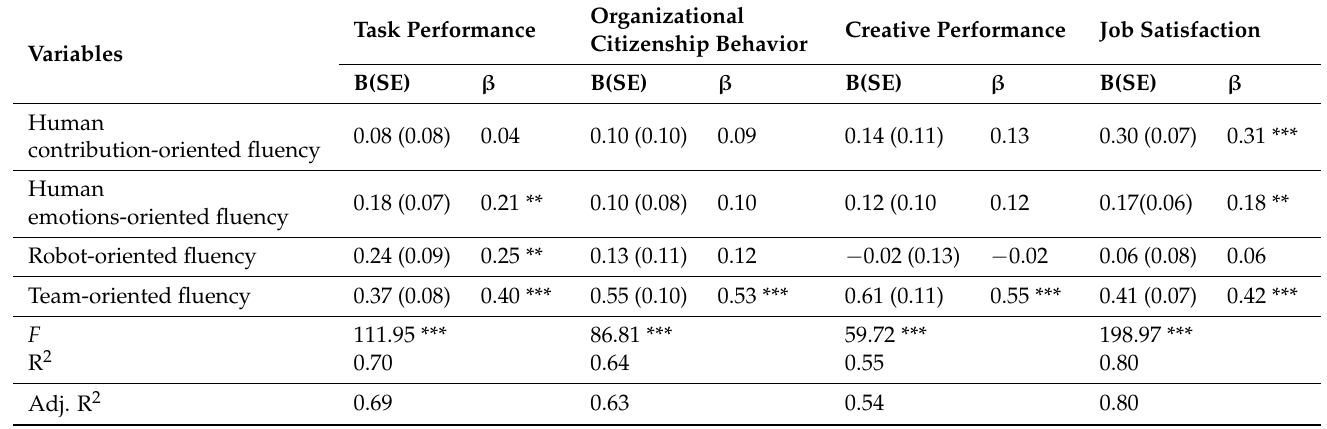
Table 3. Hierarchical regression analysis of human-robot interaction fluency factors as predictors of task performance, organizational citizenship behavior, creative performance, and job